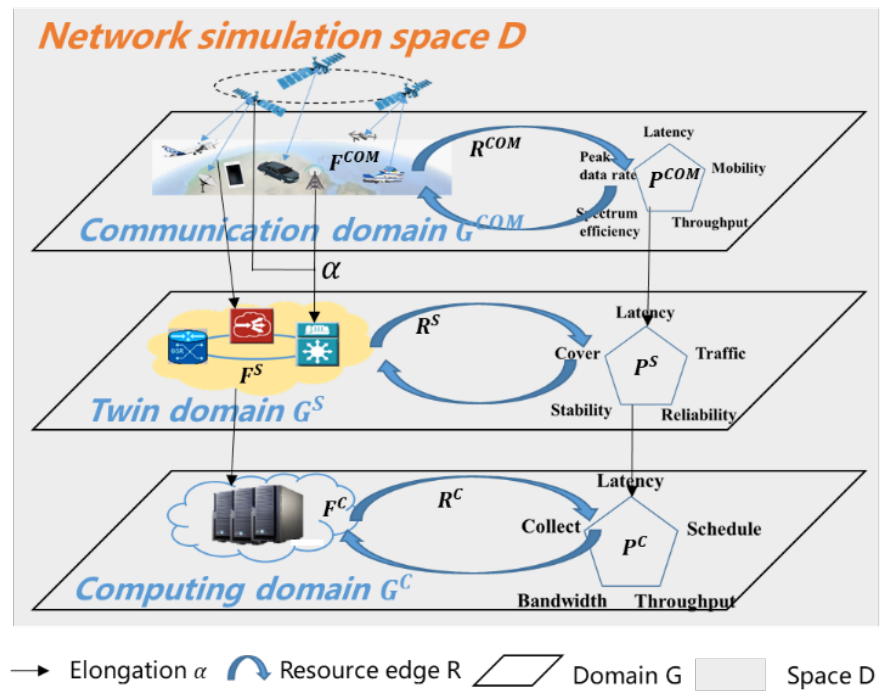
Figure 2. System